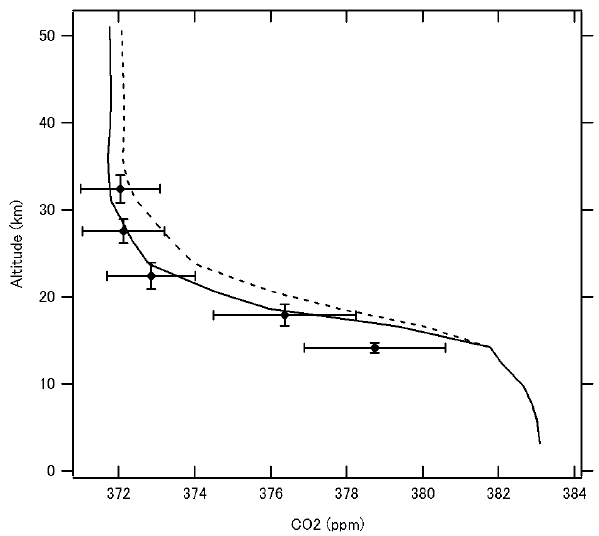
Fig. 2. Calculated CO 2 profile at 40.5 ◦ N latitude from the modeled “age of air” (lines) and the observed profile (symbols) at Sanriku, Japan (39.2 ◦ N) in January 2007. The dashed line shows the ACTM modeled profile uncorrected by the observed SF 6 age of air, and the solid line shows the profile after normalization. Error bars of the observed data show the standard deviations of the mean.